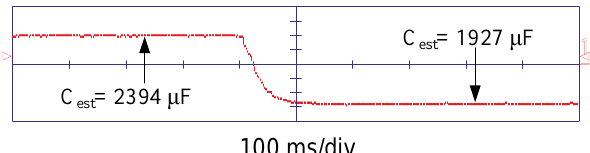
Table 5. Capacitance monitoring error.